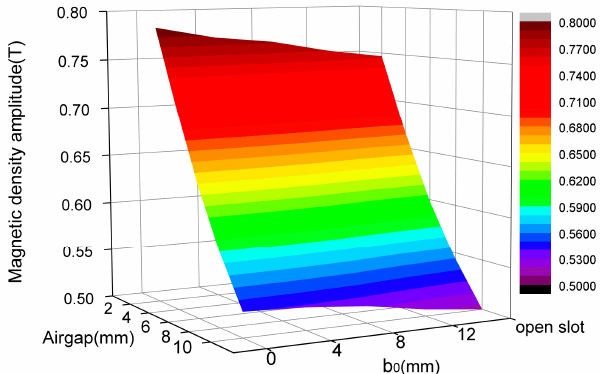
Figure 8. Amplitude of magnetic flux density.